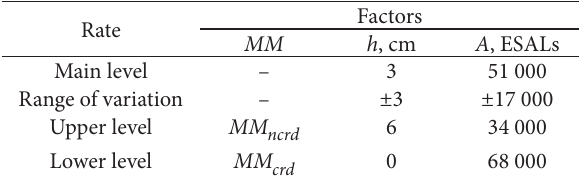
Table 1. The levels of factors and ranges of their variation Rate